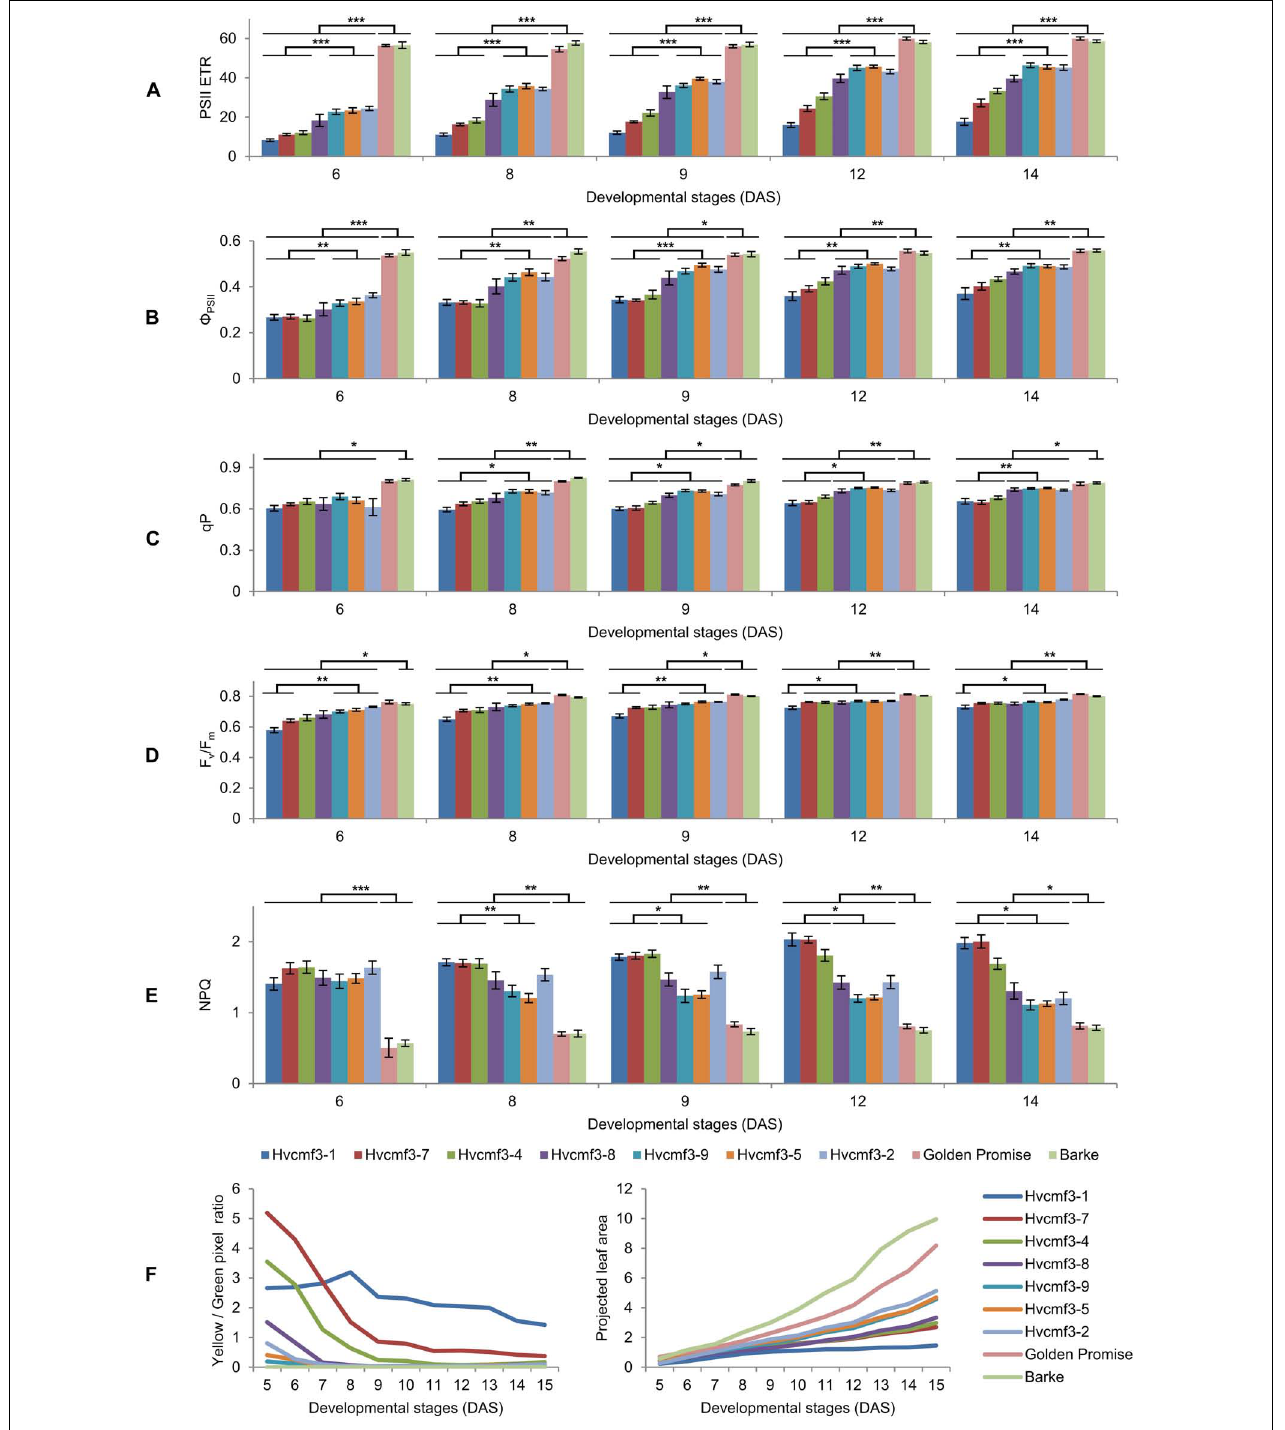
FIGURE 7 | Determination of photosynthetic parameters and growth dynamics of Hvcmf3 mutant and wild type control plants. (A–E) Measurement of photosynthetic parameters during early developmental stages. Results are presented as means ± SE. Student’s t-test significant levels, ∗ p < 0.05; ∗∗ p < 0.01, ∗∗∗ p < 0.001. Four to eight plants per genotype were analyzed. The level of significance is given for paired comparisons of either genotype within the two categories. The raw data of the LemnaTec traits is provided in Supplementary Dataset 4 , and p -values are provided in Supplementary Dataset 5 . ETR, electron transport rate; (cid:56) PSII , photosystem II operating efficiency; qP, fraction of PSII centers that are ‘open’ based on the puddle model; F v /F m , maximum quantum yield of PSII photochemistry measured in the dark-adapted state; NPQ, non-photochemical quenching. (F) Plant growth dynamics. Left panel is yellow/green pixel ratio, and right panel is projected leaf